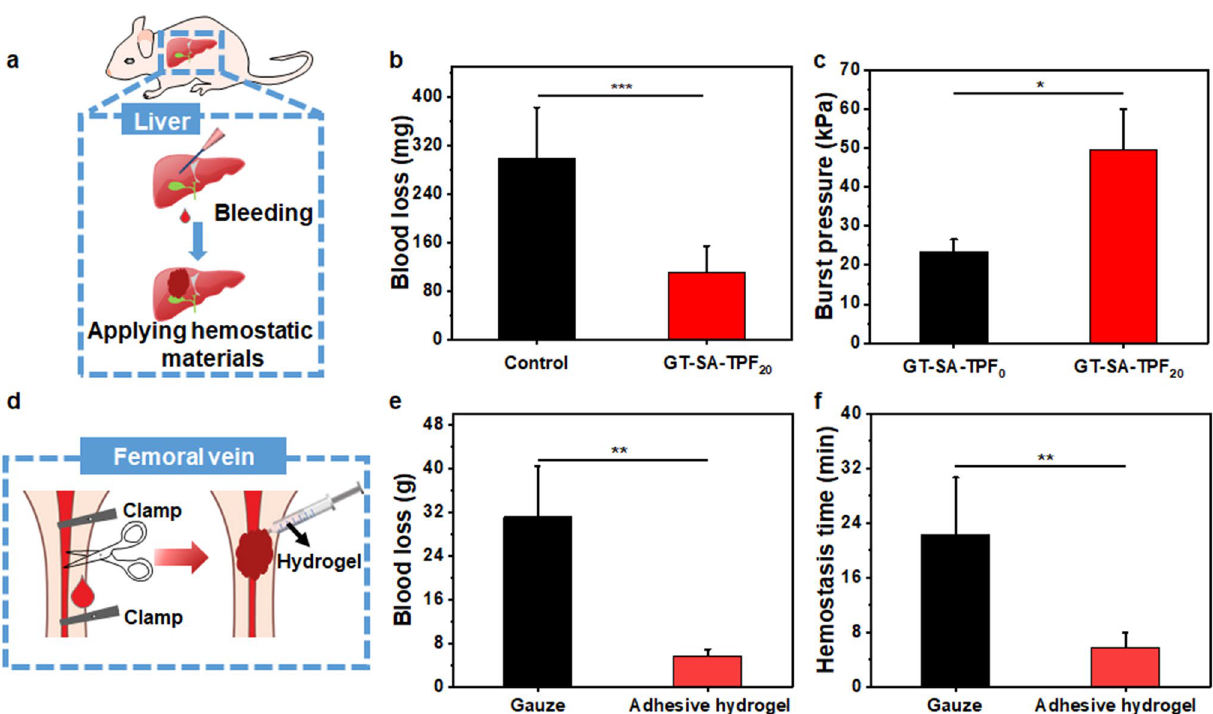
Fig. 7 Hemostasis evaluation of the hydrogels. a Illustration for the creating superficial bleeding model and stopping bleeding by using the adhesive hydrogel in mouse liver. b Blood loss of the bleeding liver treated with different strategies. c Burst pressure of the samples. d Illustra- tion for the creating acute bleeding model and stopping bleeding by using the adhesive hydrogel in rabbit femoral vein. e Blood loss and f hemo- stasis time of the bleeding femoral veins treated with different samples. * p < 0.05, ** p < 0.01, *** p <